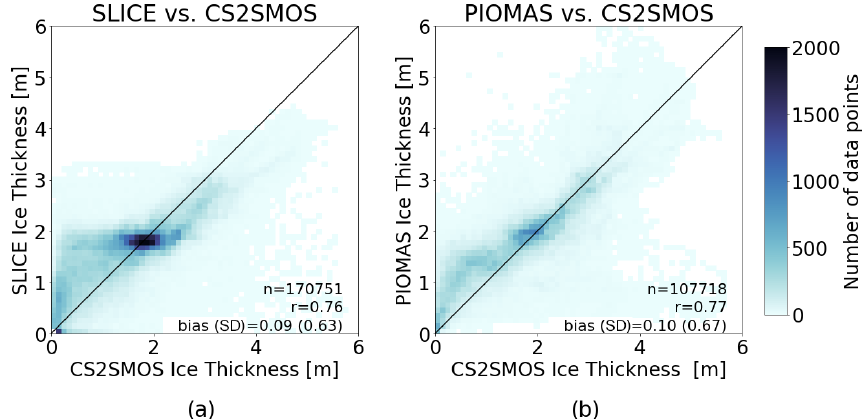
Figure 8. AWI CS2SMOS sea ice thickness versus (a) SLICE sea ice thickness and (b) PIOMAS sea ice thickness including number of data points, linear correlations, and bias (standard deviation). SLICE and PIOMAS have nearly equal mean bias and linear correlation values.